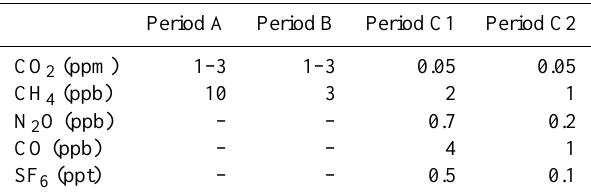
Table 2. CH 4 working standards in period A, calibrated against NOAA secondary standards, in ppb (number of injections=4).